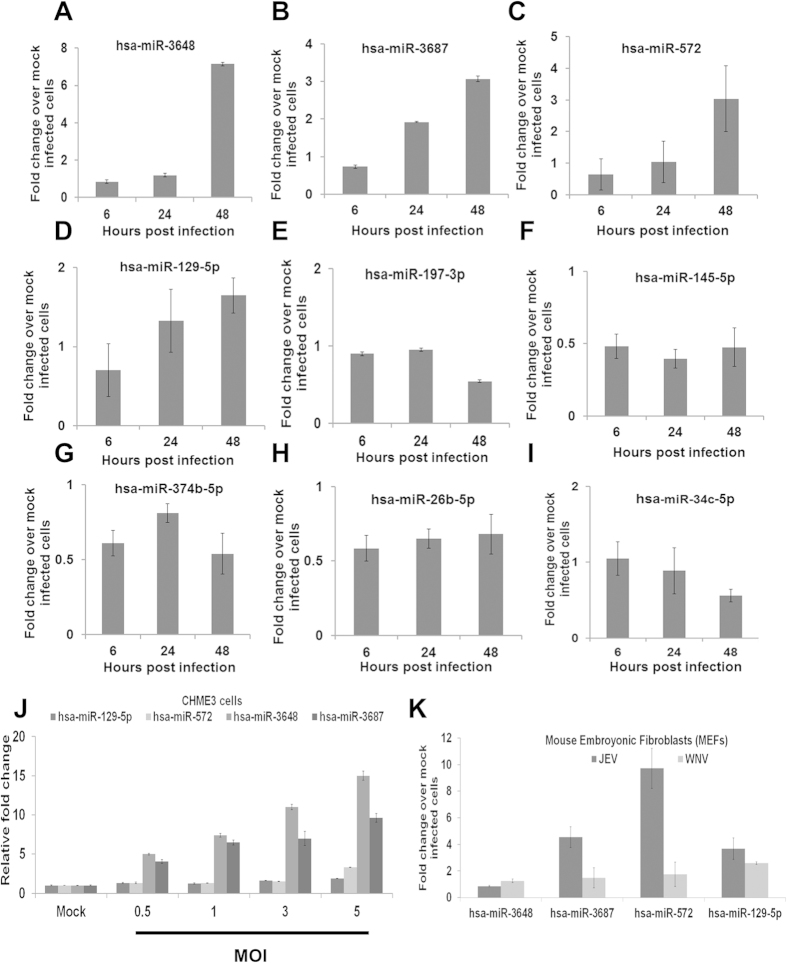
qRT-PCR analysis of miRNA expression of deregulated miRNAs in human microglia cells and Mouse Embryonic Fibroblasts (MEFs) infected with JEV and West Nile Virus (WNV).The results of qPCR analysis of (A) miR-3648, (B) miR-3687 (C) miR-572, (D) miR-129-5p, (E) miR-197-3p, (F) miR-145-5p, (G) miR-374b-5p, (H) miR-26b-5p, (I) miR-149-5p, at three different time points are presented. (J) qRT-PCR graph shows gradual increase in miR-129-5p, miR-572, miR-3648 and miR-3687 expression in CHME3 cells at increasing MOI (0.5, 1, 3 and 5 MOI) after 48 h pi. (K) qRT-PCR graph showing miR-129-5p, miR-572, miR-3648 and miR-3687 expression in MEFs cells infected with JEV and WNV after 24 h pi. Each graph represents mean absolute fold change of triplicate experiments for each miRNAs at three individual time point as compared to mock infected controls. All qRT-PCR data are represented as means ± SD. Significance is based on one way ANOVA analysis.